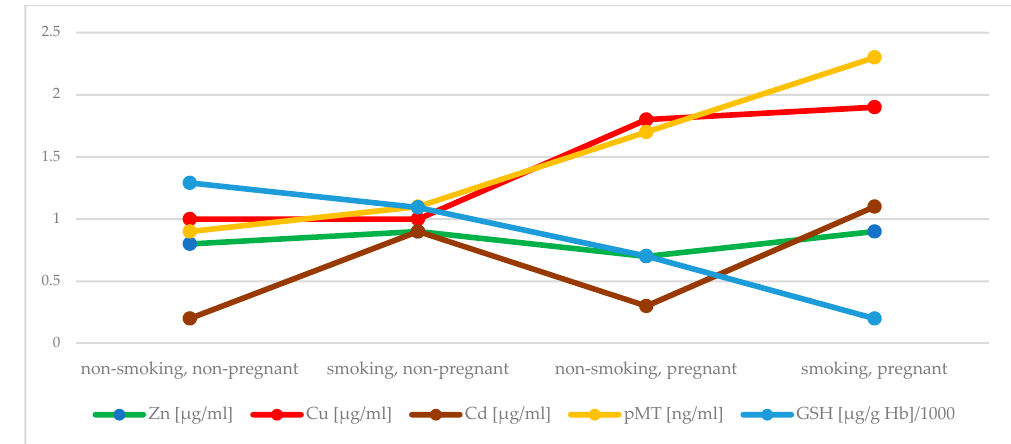
Figure 1. Comparison of the concentartion of Zn, Cu, Cd, MT in plasma and GSH between groups.